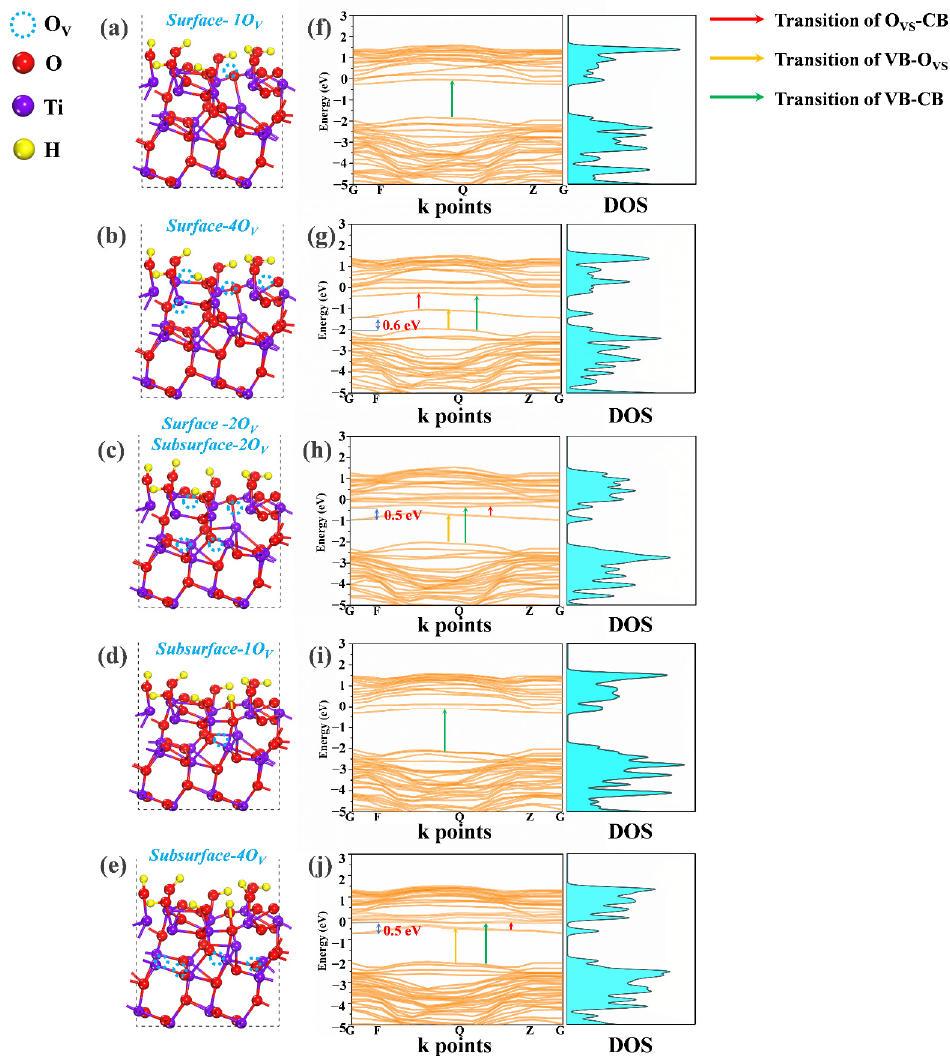
Figure 6. Five kinds of atomic models are shown in ( a – e ), respectively, and the corresponding band structure and DOS are shown in ( f – j ).